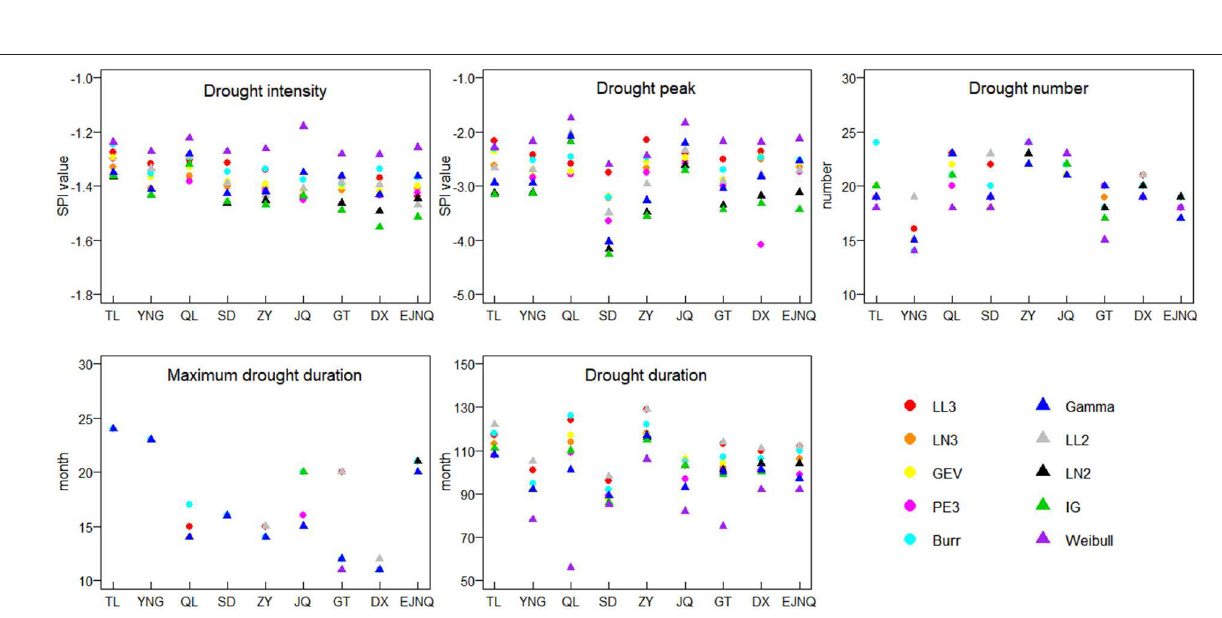
Frontiers in Earth Science |